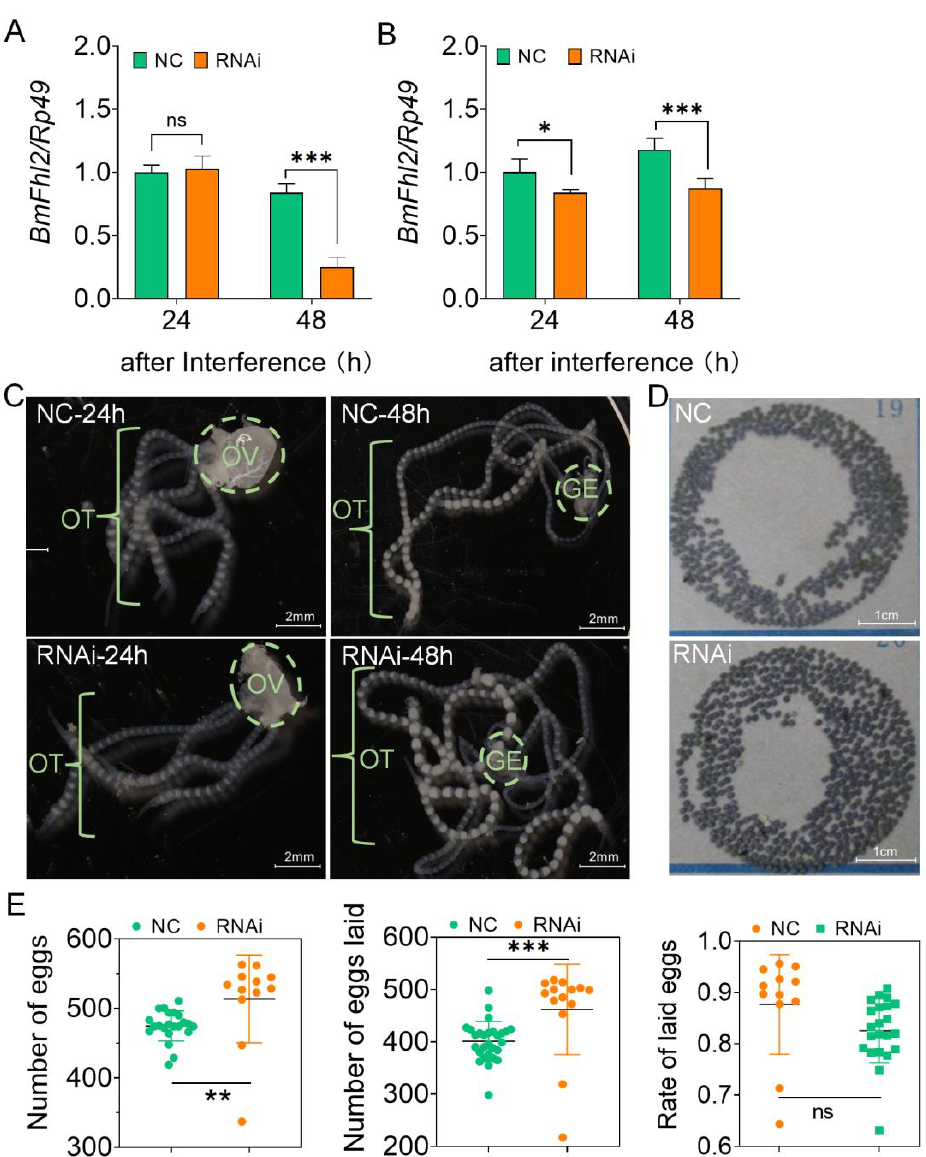
Figure 2. Effects of BmFhl2 knockdown on the reproduction of female silkworms. ( A ) Efficiency of RNAi for BmFhl2 expression in the ovary. Total RNA of the ovaries was extracted for qPCR analysis at 24 and 48 h after RNAi. All samples were collected and mixed for three silkworm populations. ( B ) Efficiency of RNAi for BmFhl2 expression in the fat body. Total RNA of the fat bodies was extracted for qPCR analysis at 24 and 48 h after RNAi. All samples were collected and mixed for three silkworm populations. ( C ) Ovarian development morphology after BmFhl2 knockdown. OT: ovarian tube, OV: ovary, GE: germarium. ( D ) Oviposition map of the NC and RNAi groups after BmFhl2 knockdown. The female moths of the two groups were mated with NC male moths. ( E ) Investigation on egg production, number of eggs laid, and the egg laying rate after RNAi. n = 11–28. Mean ± SD, N = 3. *, p ≤ 0.05; **, p ≤ 0.01; ***, p ≤ 0.001; ns: no significant difference. Rp49 was used as a reference gene. NC: injection of NC siRNA; RNAi: injection of BmFhl2